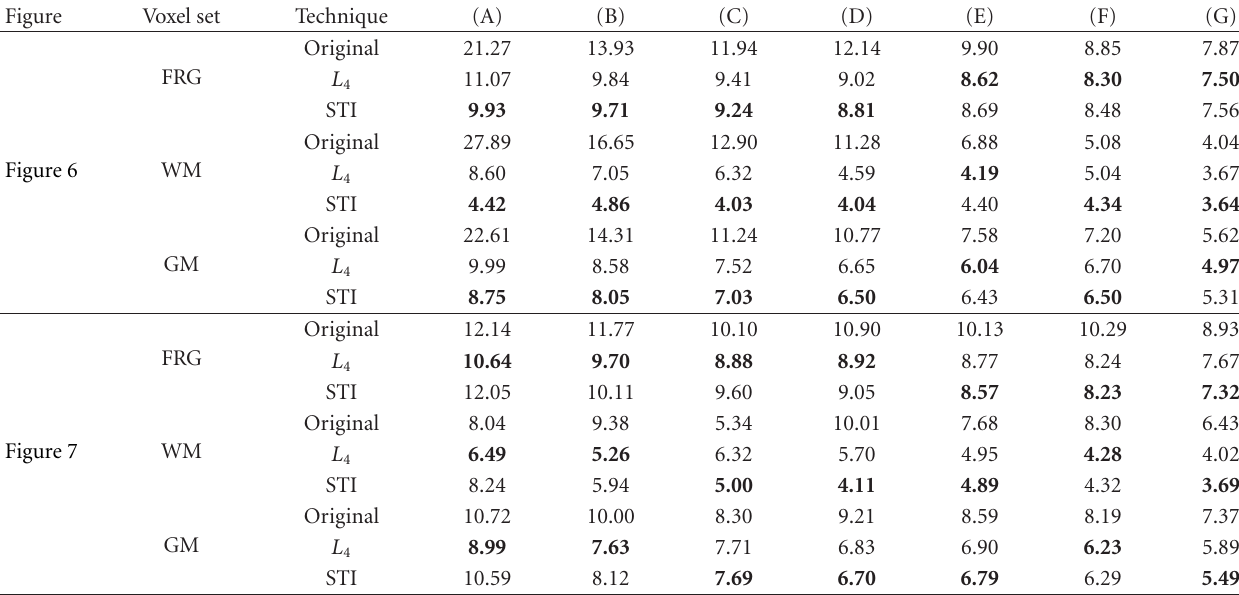
Best (lowest) MAE values are highlighted in bold